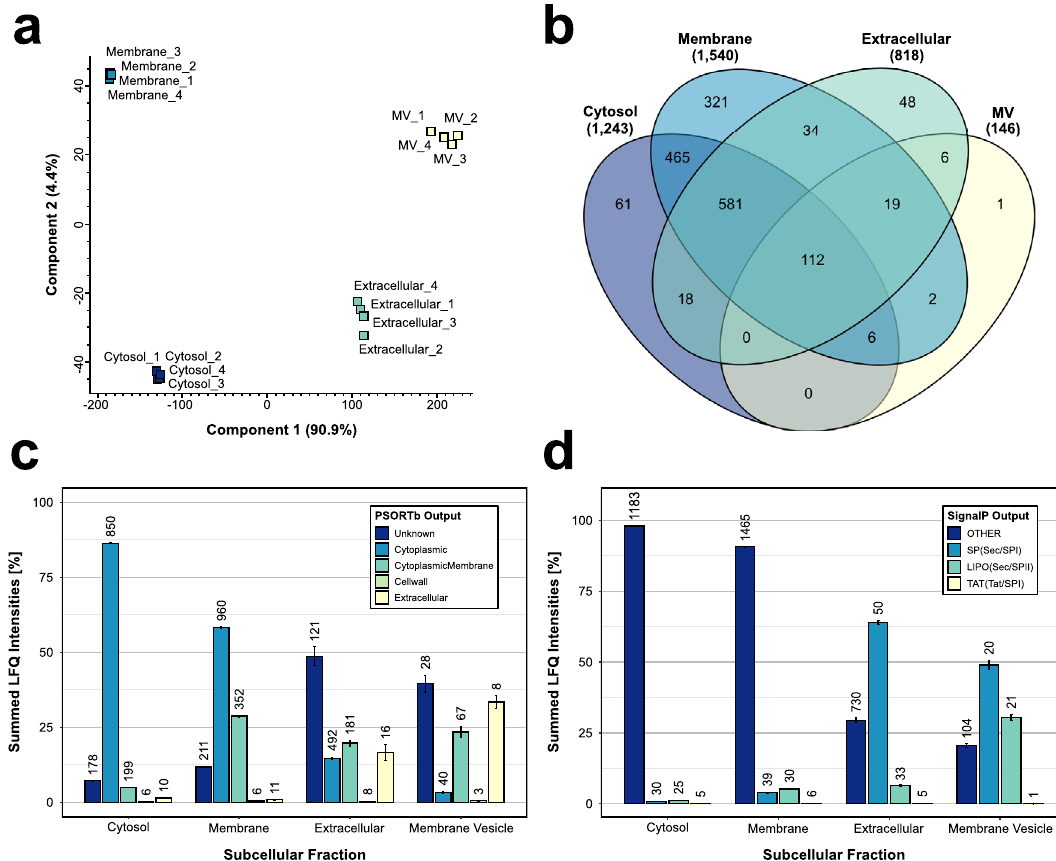
Figure 1. Overview of the protein identifications, predicted protein localizations, and predicted signal peptides for all enriched subcellular fractions: Protein abundances were only used for this figure when a protein was quantified in at least 3 out of 4 replicates in one or more of the four subcellular fractions. ( a ) Principal component analysis of the enriched subcellular fractions. Missing values were imputed from the normal distribution of each replicate (MV = membrane vesicle); ( b ) Overview of the overlap and the exclusively quantified proteins between the four enriched subcellular fractions (MV = membrane vesicle); ( c ) Illustration of the summed LFQ intensities of quantified proteins in the four subcellular fractions assigned to the respective predicted PSORTb localizations. The number of quantified proteins with the respective PSORTb prediction in each of the subcellular fractions is indicated above the bars; ( d ) Illustration of the summed LFQ intensities of quantified proteins in the four subcellular fractions assigned to the predicted SignalP protein signal peptides. The number of quantified proteins with the respective SignalP signal peptide prediction within the subcellular fractions is indicated above the